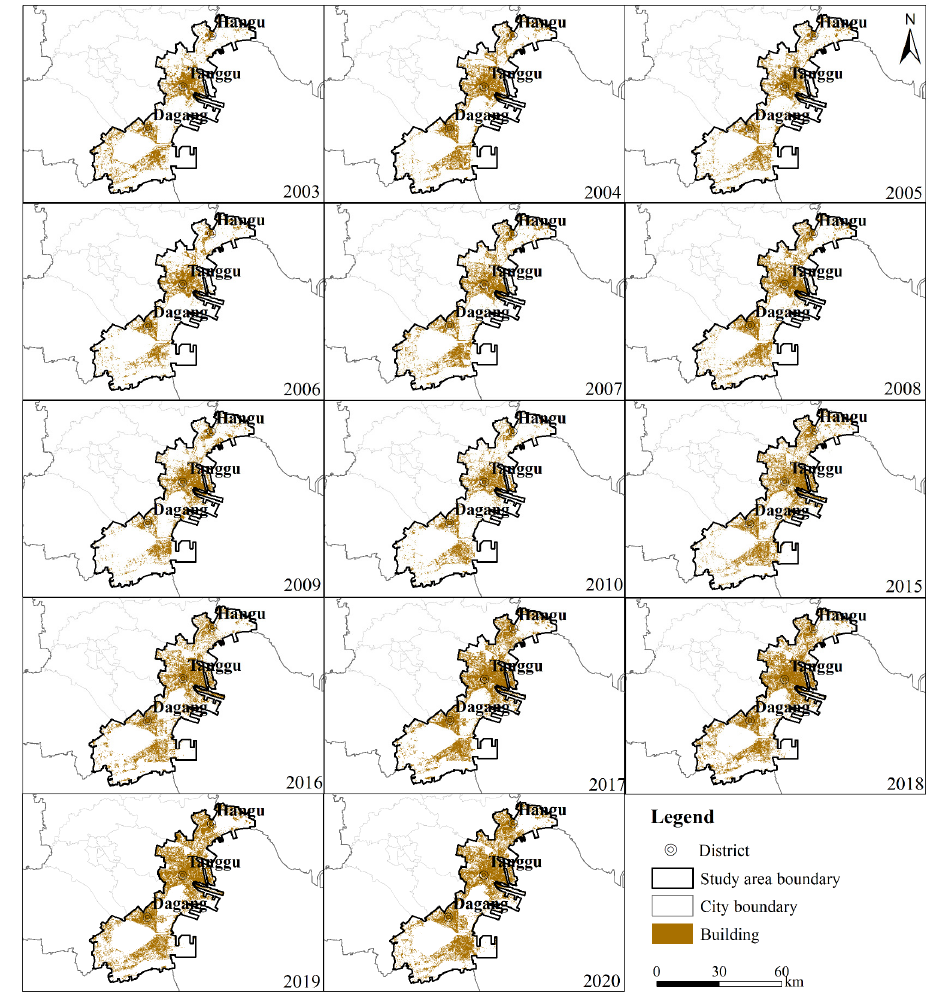
Figure 7. Distribution of buildings in the study area from 2003 to 2010 and 2015 to 2020. Buildings are mainly distributed in the middle and southern parts of the study area.